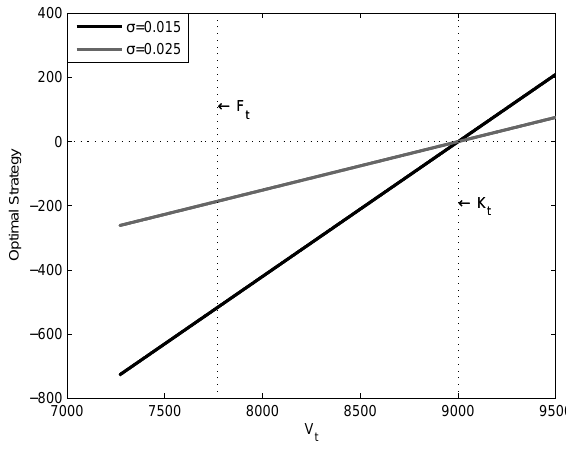
Figure 4. Optimal Strategy versus Value of the Pension Fund for different values of σ when ( γ = 1.2).